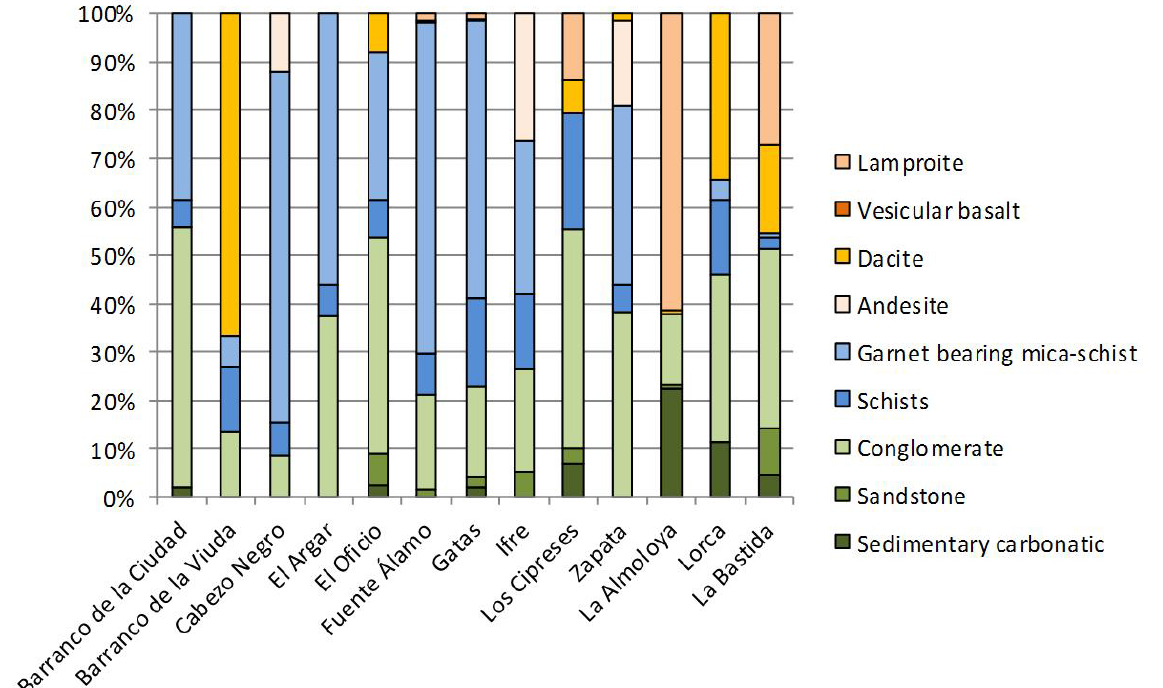
Figure 7. Frequency of lithologies used for the production of grinding slabs in different Argaric